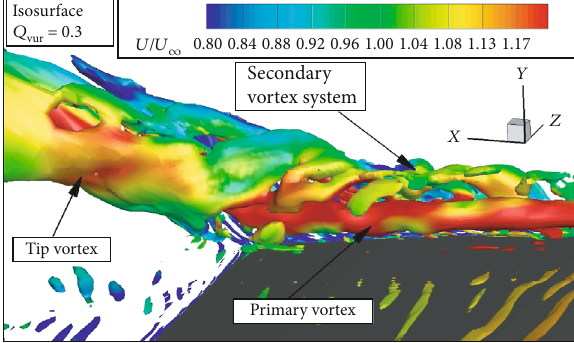
Figure 9: Wingtip vortex structure at the trailing edge of clean